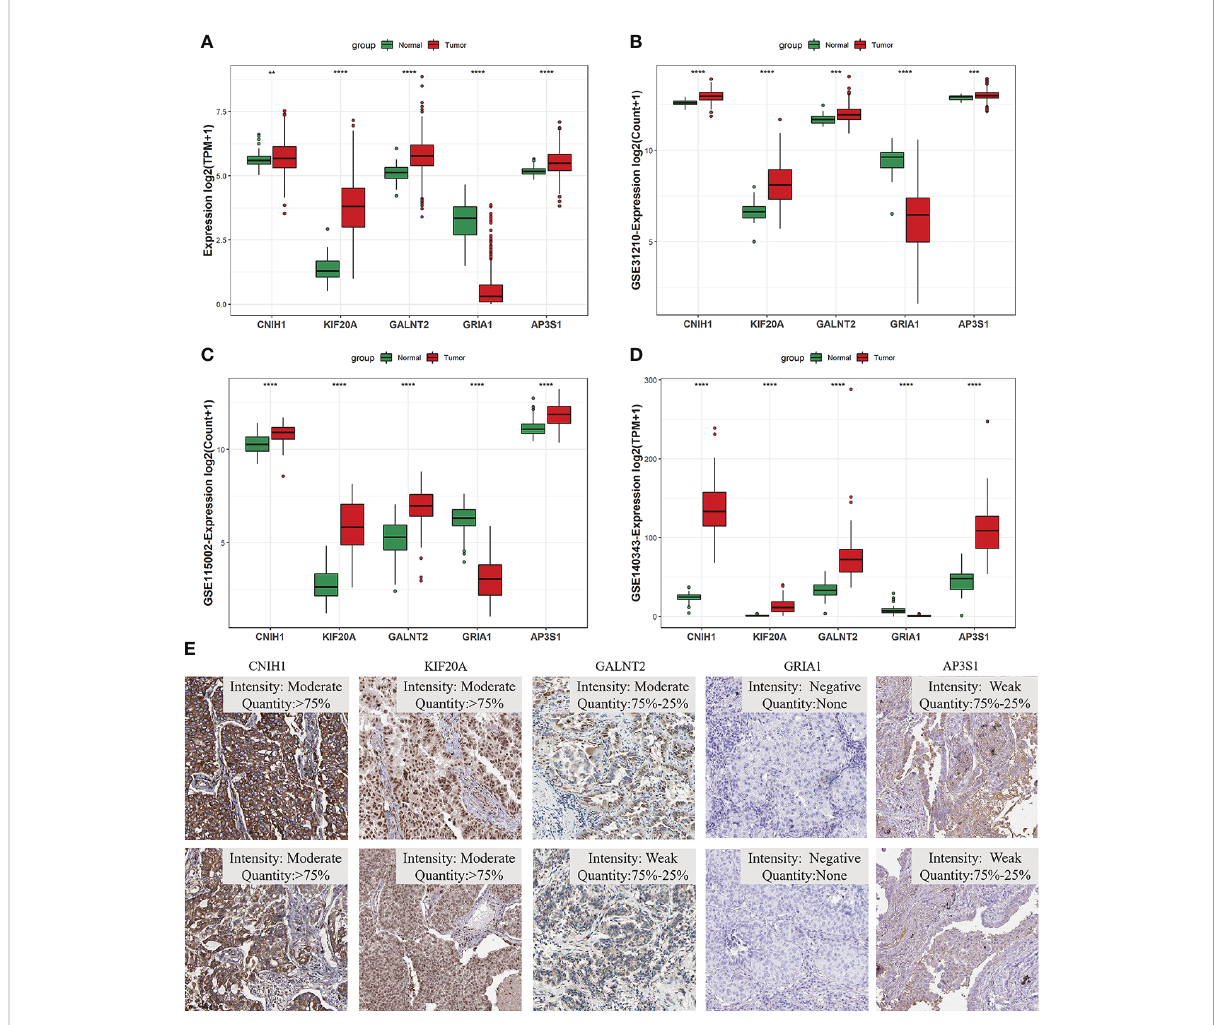
FIGURE 4 The expression of fi ve hub genes in prognostic model in LUAD. (A – D) Differential expression of CNIH1 , KIF20A , GALNT2 , GRIA1 , and AP3S1 between tumor tissues and adjacent tissues in the TCGA database (A) and in the three GEO sets [GSE31210 (B) , GSE140343 (C) , GSE115002 (D) ]. (E) CNIH1, KIF20A, GALNT2, GRIA1, and AP3S1 protein levels in 10 LUAD patients from the HPA database. ** p <0.01, *** p <0.001, **** p